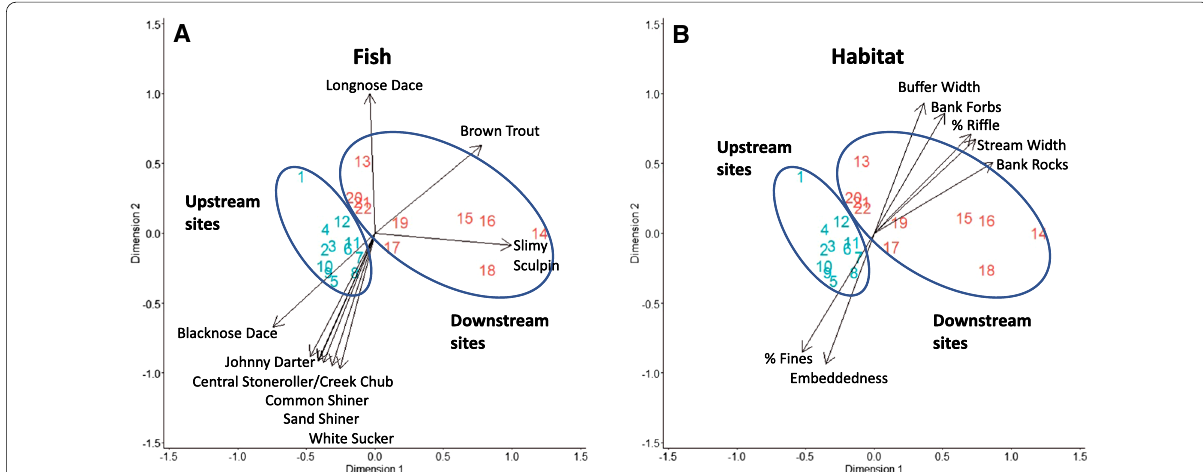
Fig. 2 Non-metric multidimensional scaling ordination (NMDS) biplots of 22 stream sites on the South Fork Whitewater River, Minnesota, USA, based on abundances of fish and stream habitat variables at each site. Numbers represent sites (see Fig. 1), separate ellipses enclose the 12 upstream sites and the 10 downstream sites, and arrows represent locations of greatest abundance for fish ( A ) and strongest influence of stream habitat variables ( B ) whose values were statistically ( α